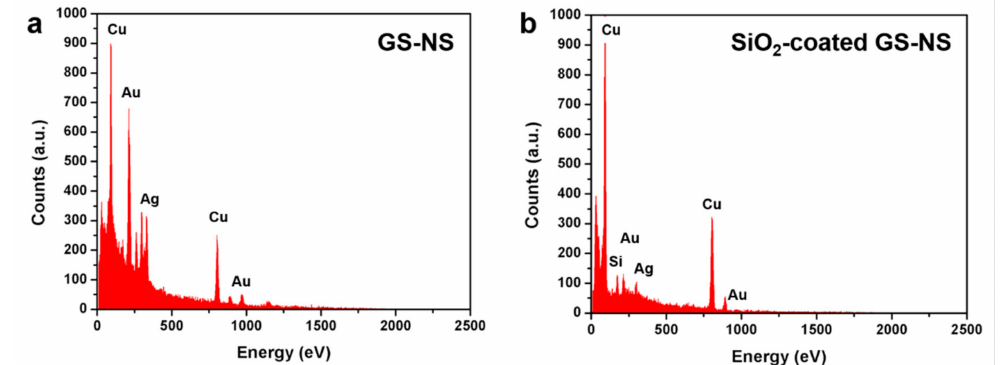
Figure 4. EDX spectra of ( a ) gold-silver nanoshells and ( b ) SiO 2 -coated gold-silver nanoshells having a 2 nm thick silica